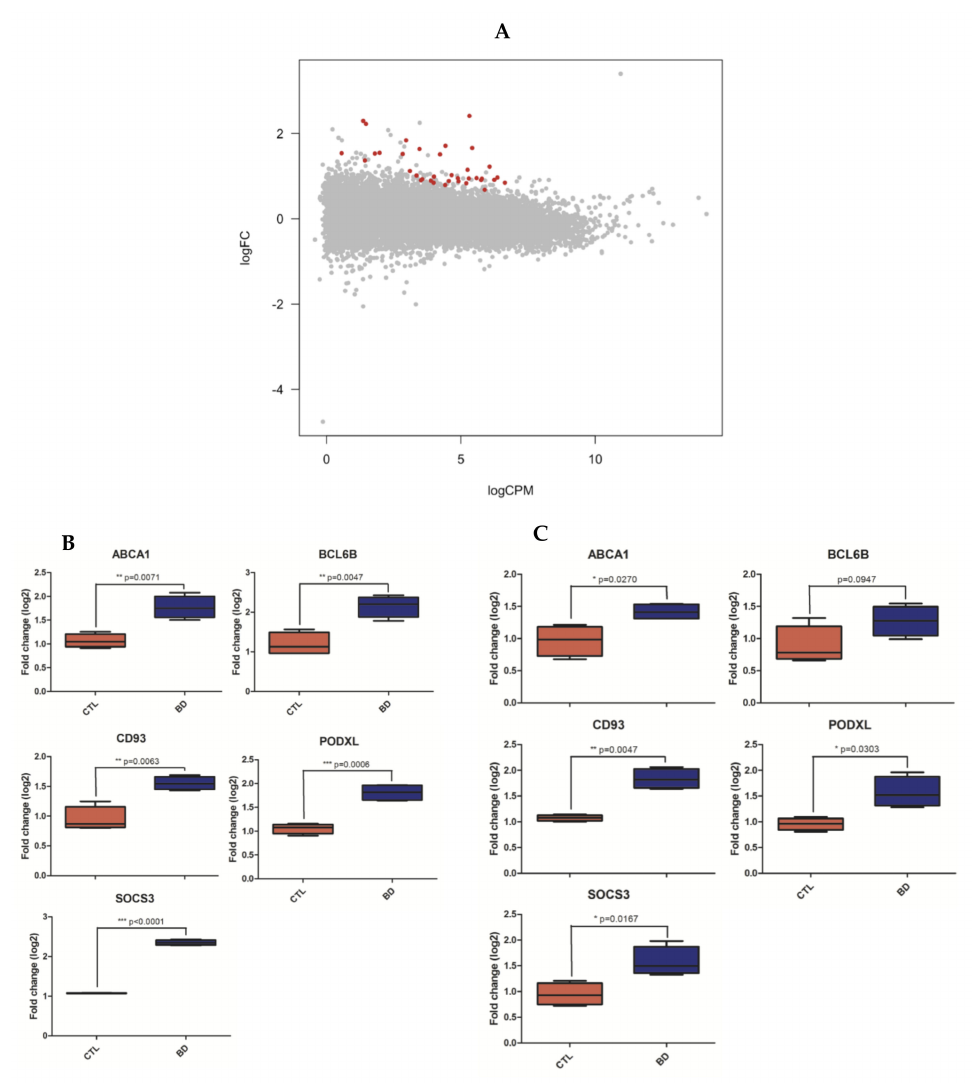
Figure1. Di ff erentiallyexpressedgenesanalyses. Plotshowingthe36significantdi ff erentiallyexpressed genes (DEGs) at FDR < 0.1 in subjects with BPD (blue) versus healthy controls (red, A ). Validation ( B ) and replication ( C ) of RNAseq gene expression analysis by RT-qPCR. RNA level di ff erences were calculated by unpaired Welch t-test (* p < 0.05, ** p < 0.01, *** p < 0.005). All 5 DEGs were successfully validated by RT-PCR and had significant increased expression levels in BPD patients compared to controls ( B ). Four out of five DEGs were successfully replicated and had increased expression levels in BPD patients compared to controls; only BCL6B did not replicate significantly, although its expression level aligned with the sequencing data ( C